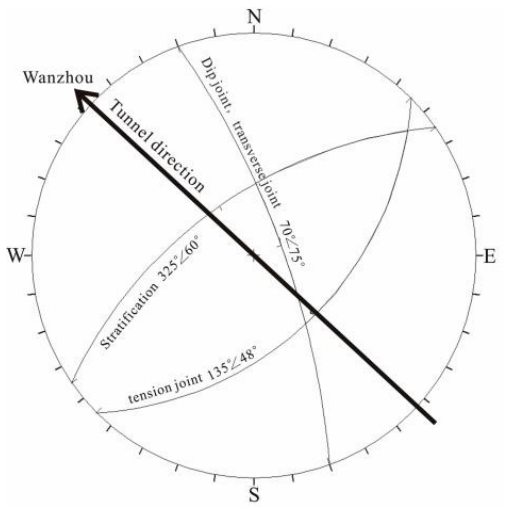
Figure 11. The stereographic projection method of the joint distribution.